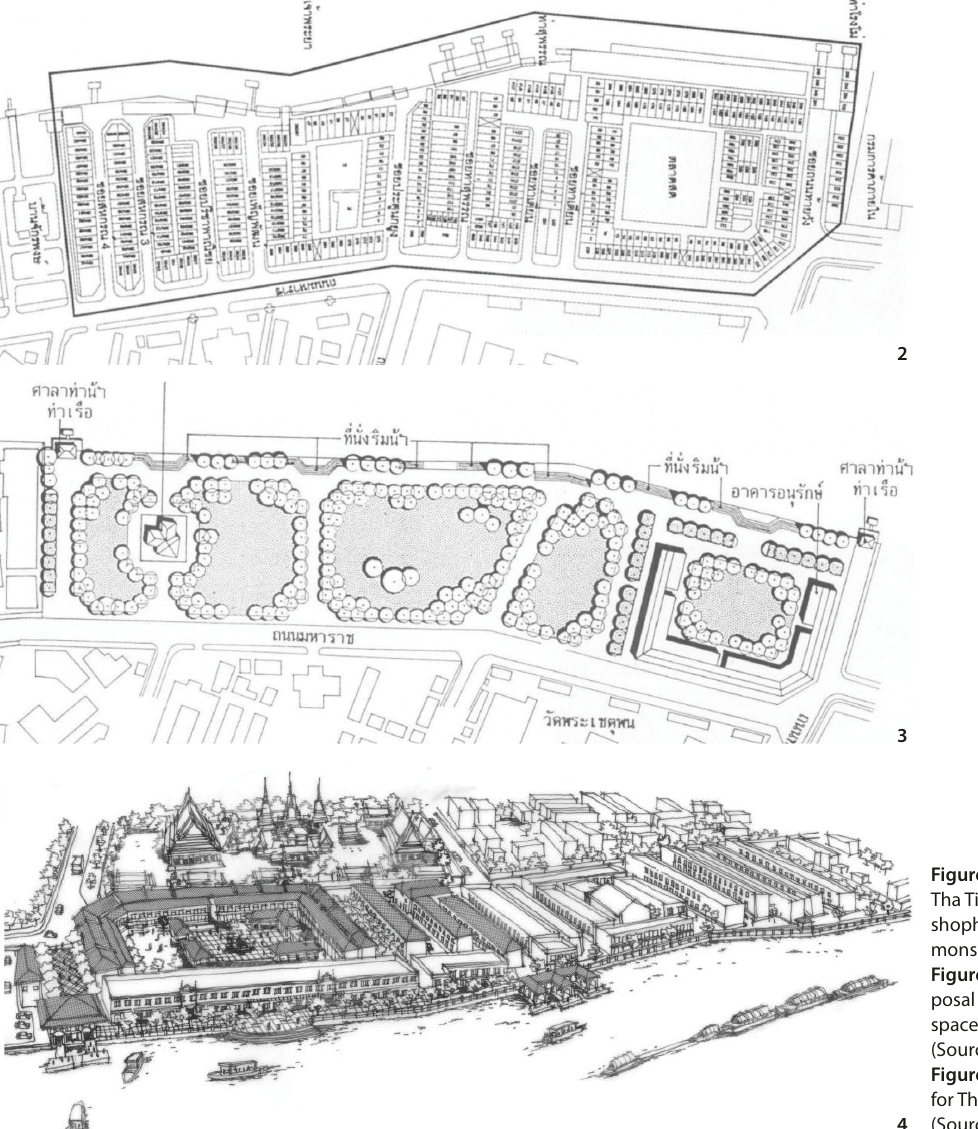
Figure 2 Existing condition of Tha Tian community with 490 shophouses, 2006 (Source: Pi- monsathean). Figure 3 The master plan pro- posal with provision of open space via shophouse demolition (Source: Synchron Group). Figure 4 Alternative proposal for Tha Tian Conservation, 2006 (Source: